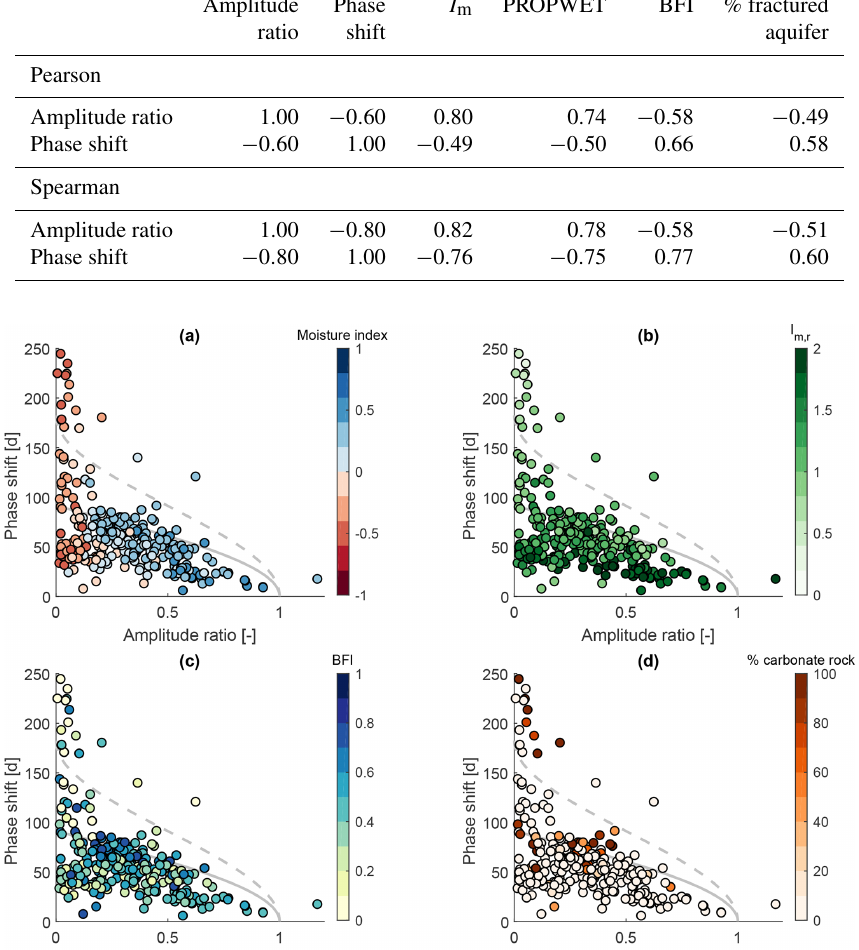
Table 2. Pearson and Spearman correlation coefficients between seasonal signatures and catchment attributes for UK catchments.